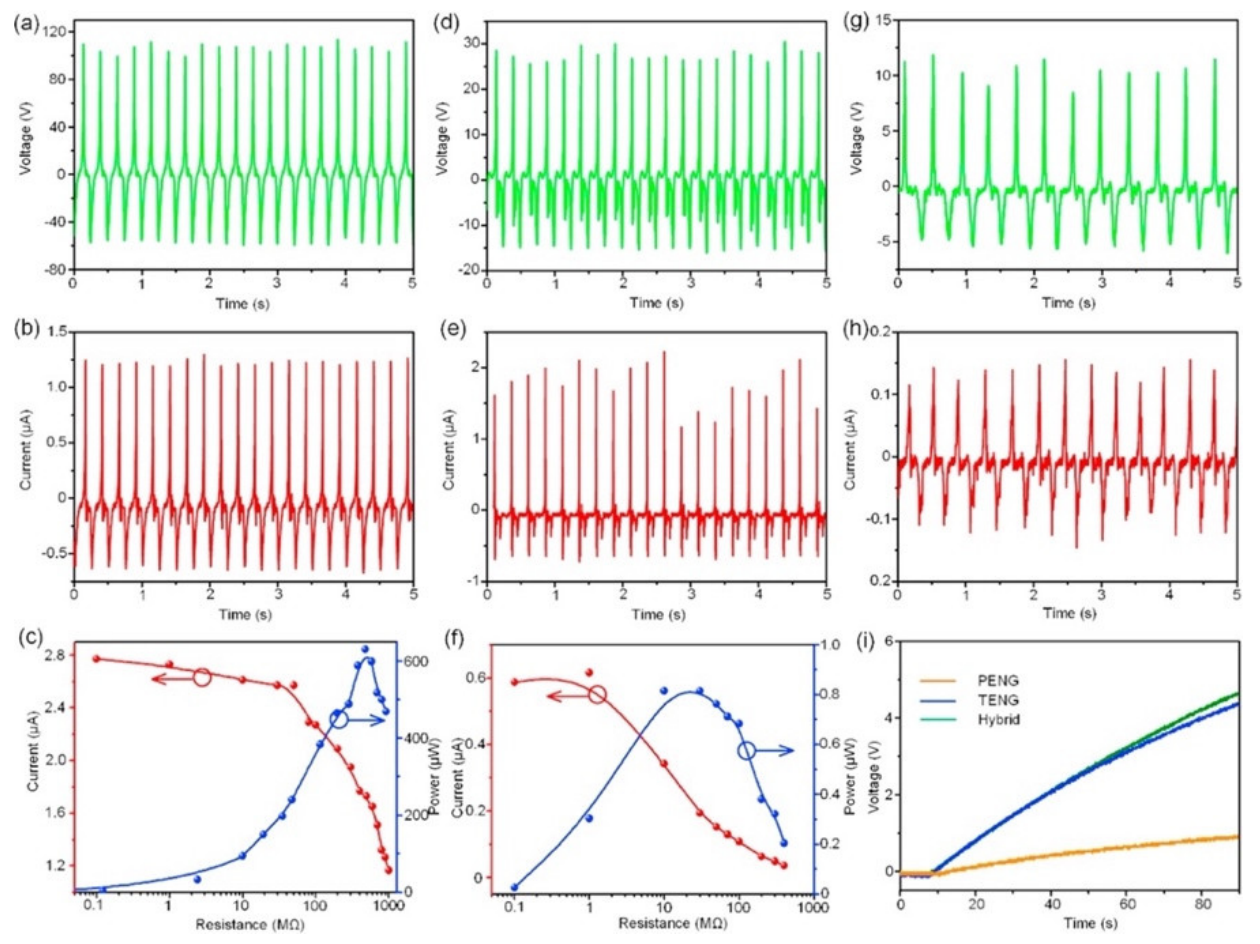
Figure 3. Electrical output performance of the flexible hybrid nanogenerator reported by Chen et al. [103]. ( a ) The output voltage, ( b ) current, and ( c ) maximum peak power as a function of resistance load of the TENG module. ( d ) The output voltage, ( e ) current, and ( f ) maximum peak power versus resistance load of the PENG module under compression. ( g ) The output voltage and ( h ) current of the PENG module under bending mode. ( i ) The charge voltage of a capacitor of 1 μF using the hybrid nanogenerator. Reprinted with permission from [103]. Copyright 2017, Elsevier Ltd.